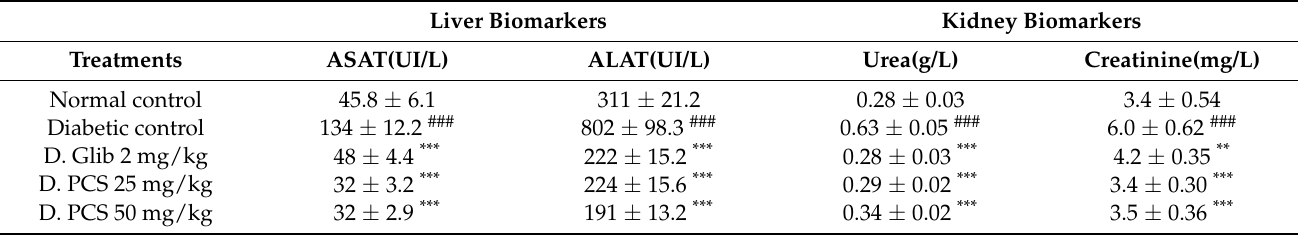
Table 3. Biochemical parameters of the experimental groups at the end of the study period. Liver Biomarkers Kidney Biomarkers Treatments ASAT(UI/L) Creatinine(mg/L) Normal control Diabetic